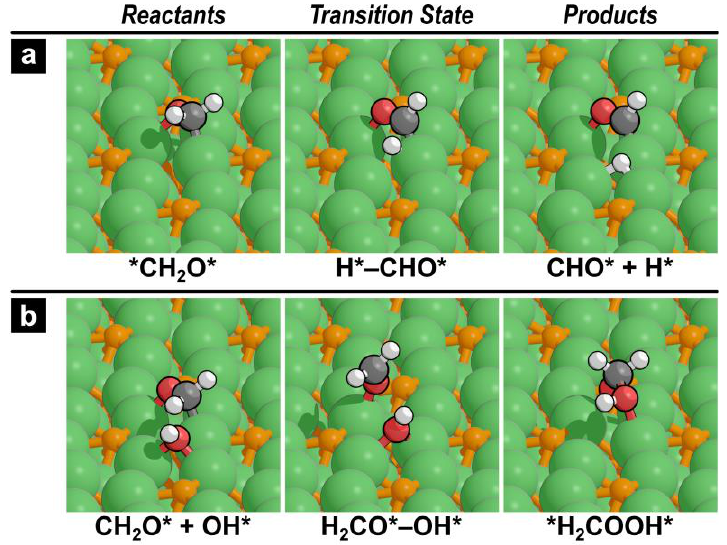
Figure 3. Reactants, transition state, and product structures for ( a ) formaldehyde decomposition to CHO* (reaction 5) and ( b ) for formaldehyde reaction with OH* (reaction 7). Similar images for all other reactions can be found in Figure S1 in the Supporting Information.